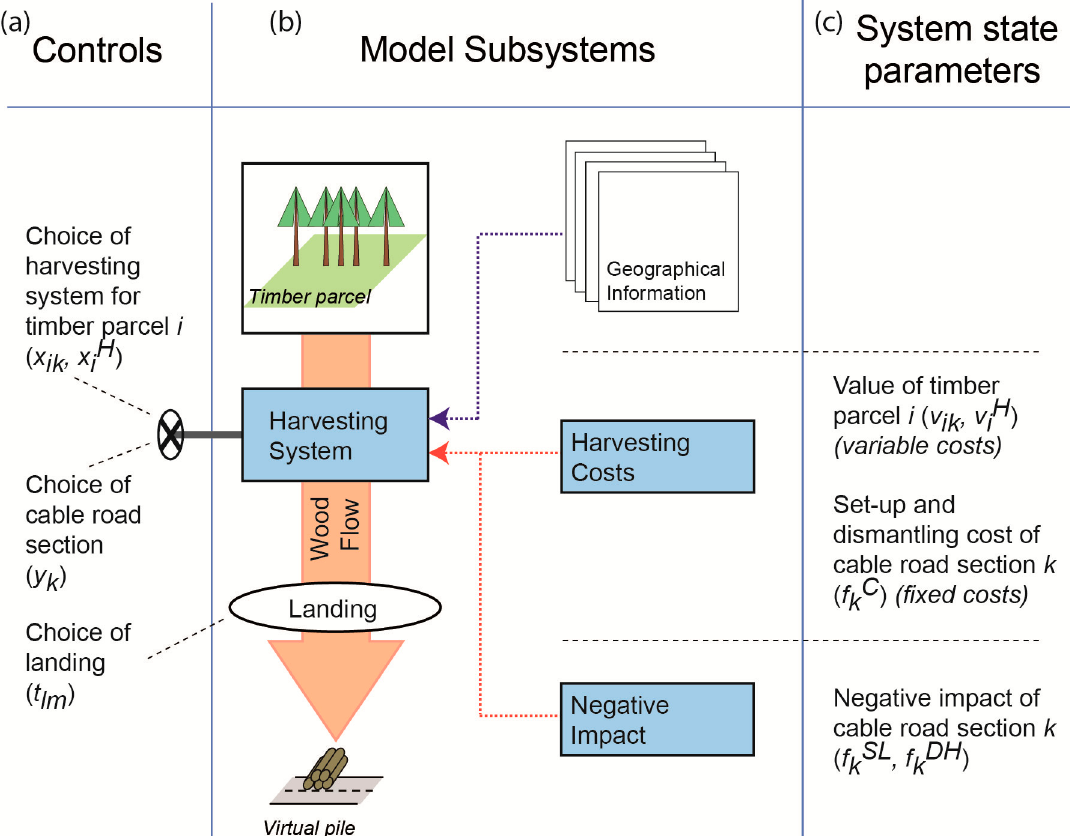
Figure 1. Conceptual model with controls, i.e., decision variables ( a ), model subsystems ( b ), and system state parameters ( c ).